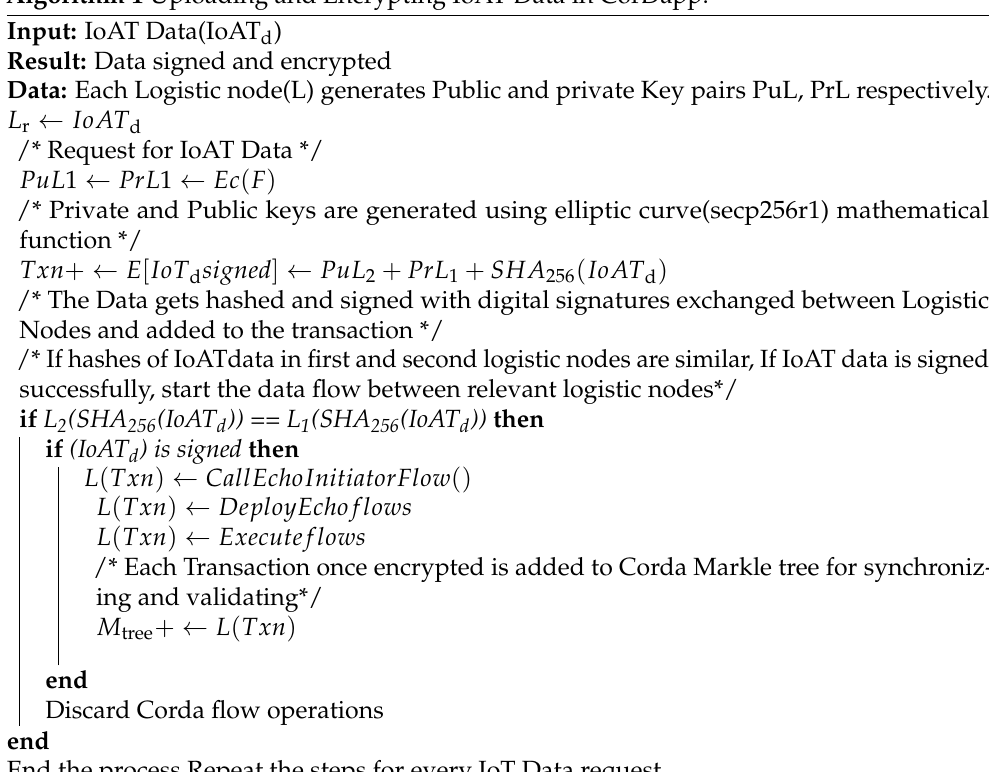
Algorithm 2 Accessing and Decrypting IoT